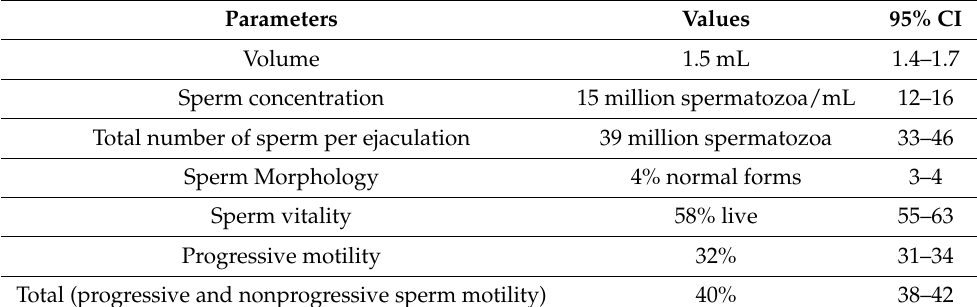
Table 1. Normal semen parameters with values at 95% confidence intervals (CI), according to the WHO.